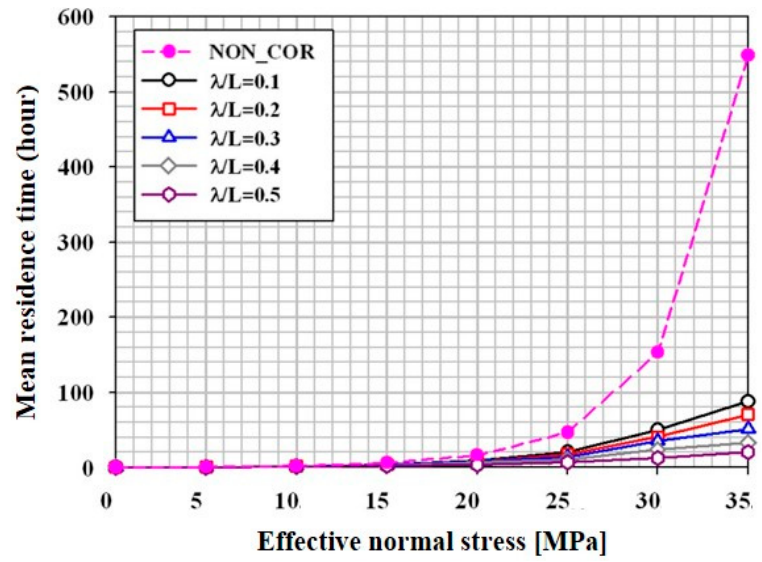
Figure 7. Comparison of the mean residence time based on λ / L and σ (cid:48) .